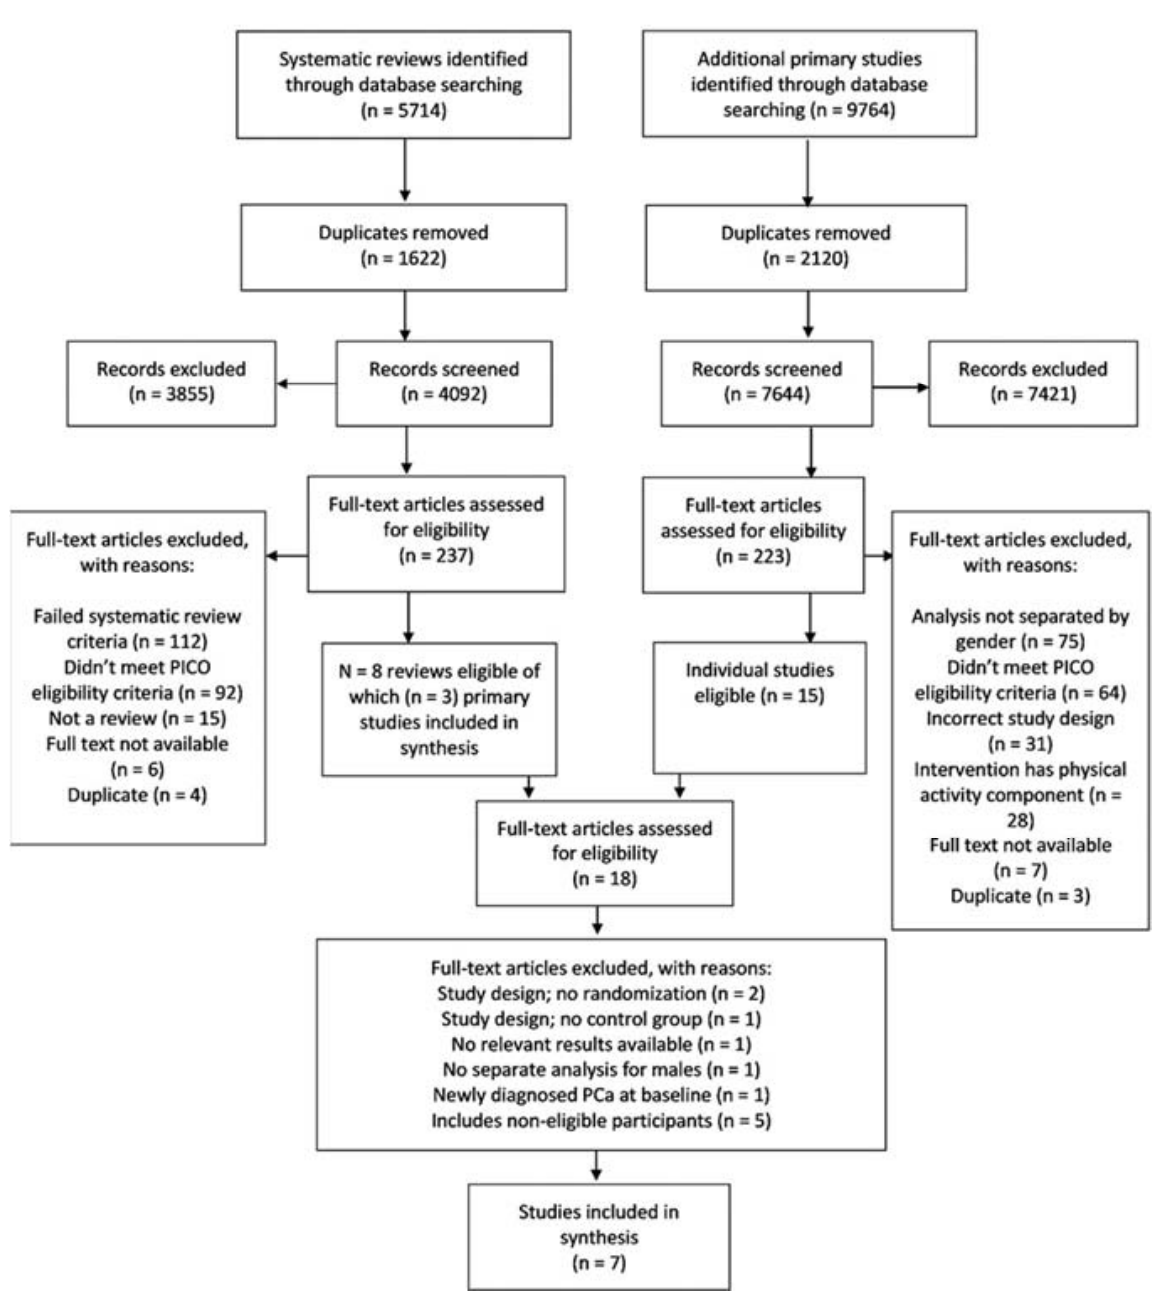
Figure 1. Flow diagram of body fatness–insulin association studies identified and included.